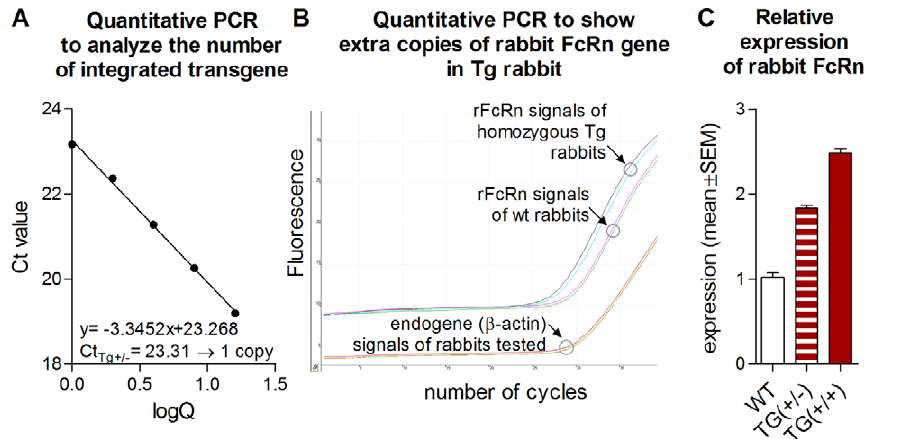
Figure 7. Quantitative real time PCR analysis of transgenic rabbit line # 78. We determined the copy number of the transgene integrated into the genome and its expression levels by real time PCR. A. Quantitative PCR standard curve and equation to determine the exact copy number of the transgene. According to the linear regression calculation, the 23.31 Ct value that represents the hemizygous line # 78 (TG + / 2 ) results in 0.97 which corresponds a single copy integration event (Q represents copy number). B. We also detected the integrated extra copies of the rabbit FcRn gene in homozygous Tg rabbits by quantitative genomic PCR. C. Relative rabbit FcRn expression levels in hemizygous and homozygous transgenic line # 78 shows expression of the transgene in leukocytes of the animals tested. Values shown are the mean 6 SEM. TG ( + / 2 )- transgenic hemizygous, TG ( + / + )- transgenic homozygous, WT- control animals.